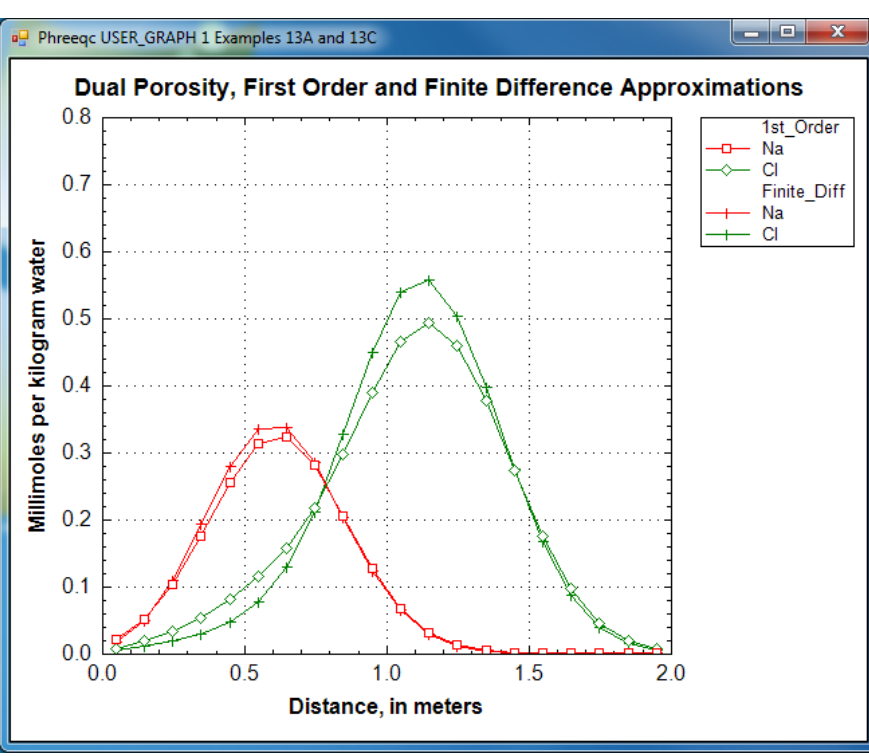
Figure 14. Results of simulations of transport with diffusion into spherical stagnant zones modeled by using finite difference and first-order exchange